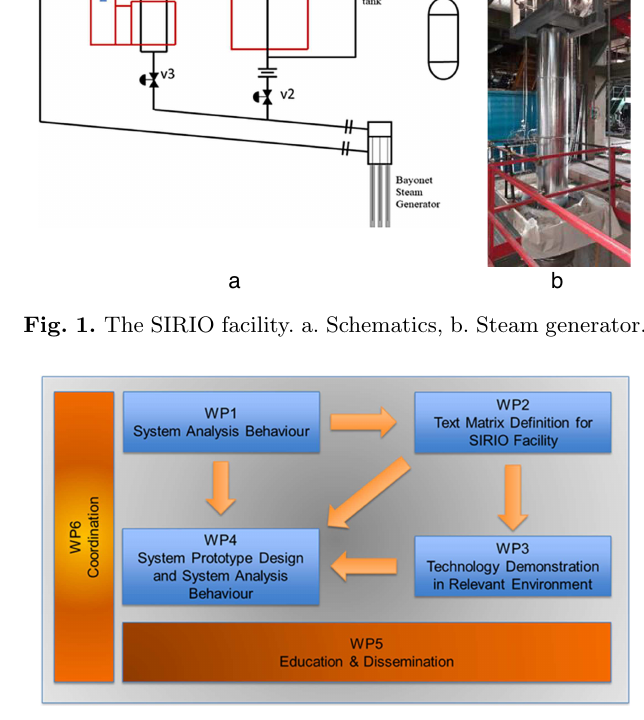
Fig. 2. PIACE Functional